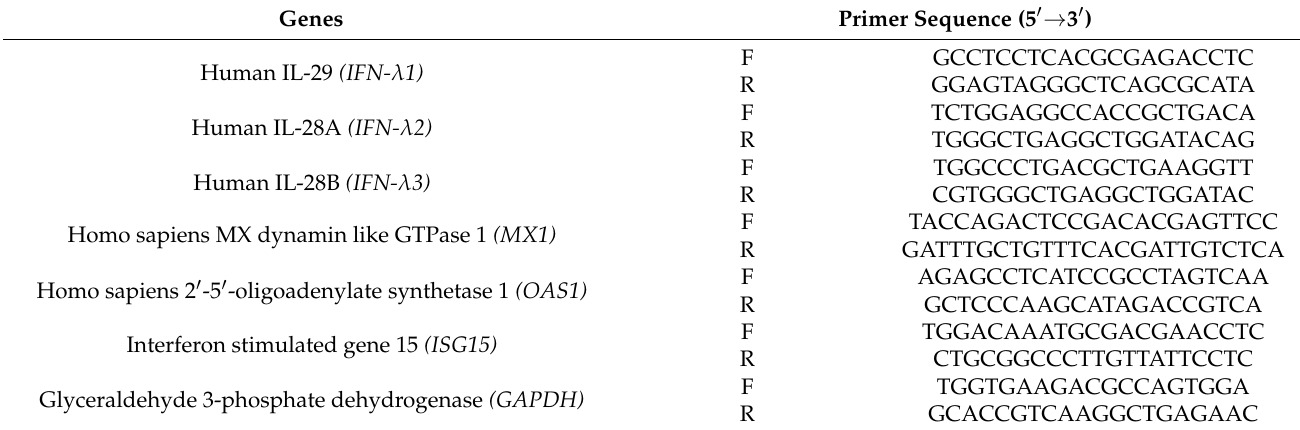
Table 1. Primers sequences 1